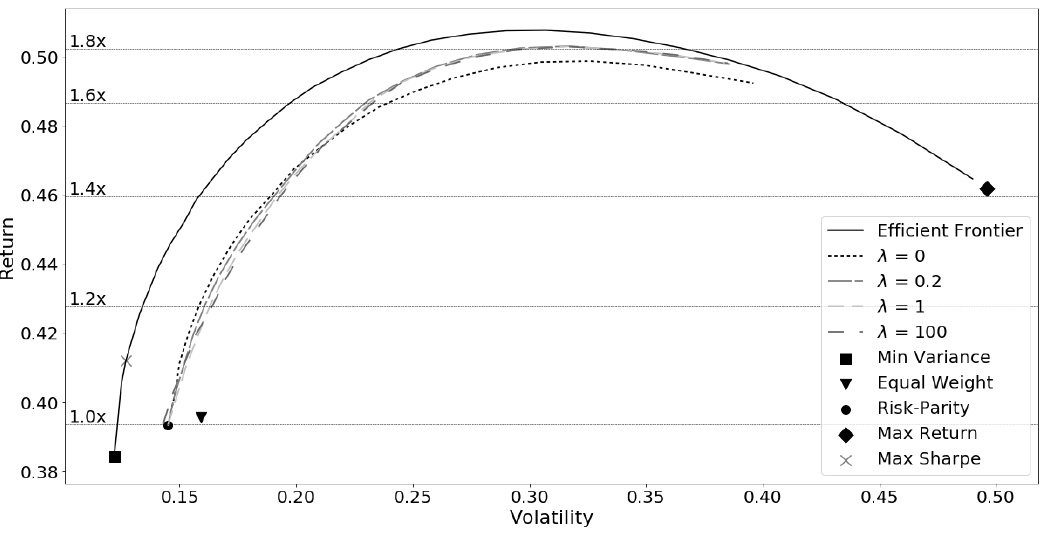
Figure 6. Relaxed Risk Parity Efficient Frontier-1992–2018.